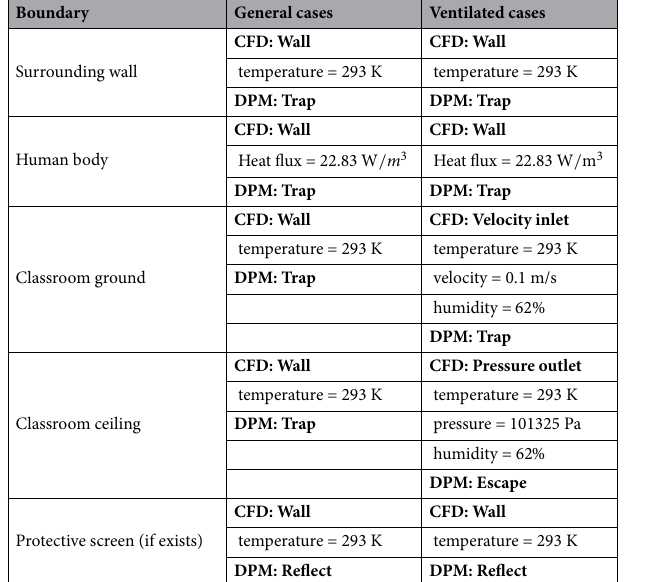
Protective screen (if